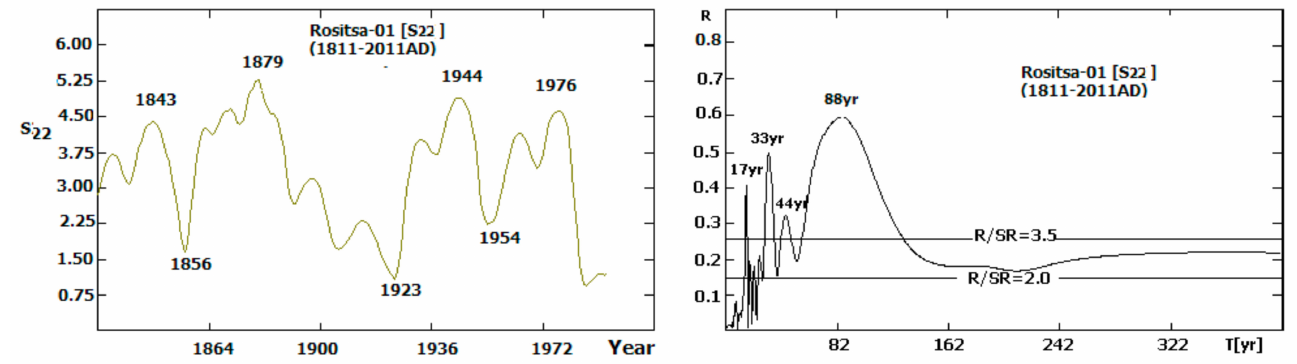
Figure 7. Left : The amplitude index S22 of “Gurkovo-01” beech sample Dm-series. The moving window width is equal to 30 years; right : the corresponding T – R